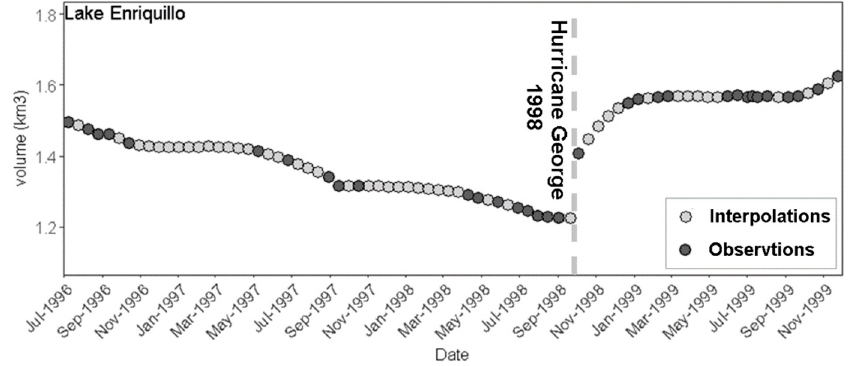
Figure 4. Lake Enriquillo 1996–1999 observed and interpolated values as an example for incorporating a storm event in the interpolation process. a storm event in the interpolation